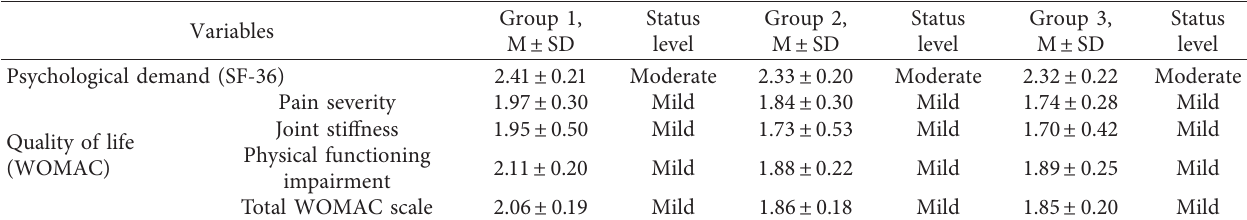
Table 5: The duration differences of quality of life among patients after TKR ( N � 118).